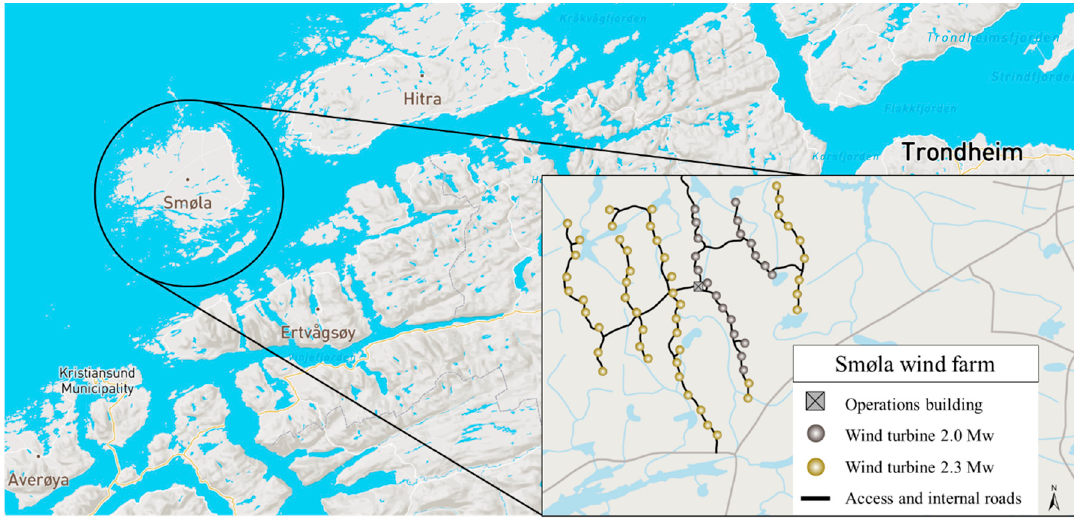
Figure 1. Location of Smøla island in Norway [36]; right corner: Focus on the Smøla wind farm; showing the web of turbines located on the island [34].